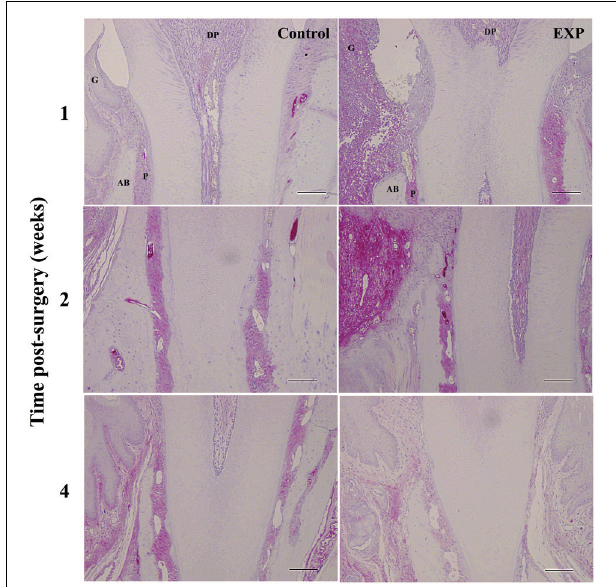
FIGURE 4 | Time-course observations of SDF-1 expression around periodontal tissue defects. In experimental sites, SDF-1 expression was slightly higher at 1 week after surgery when compared with controls. SDF-1 expression peaked at 2 weeks after surgery in experimental tissue. SDF-1 expression decreased to control levels by 4 weeks. G, gingiva; AB, alveolar bone; P, periodontal ligament; DP, dental pulp.